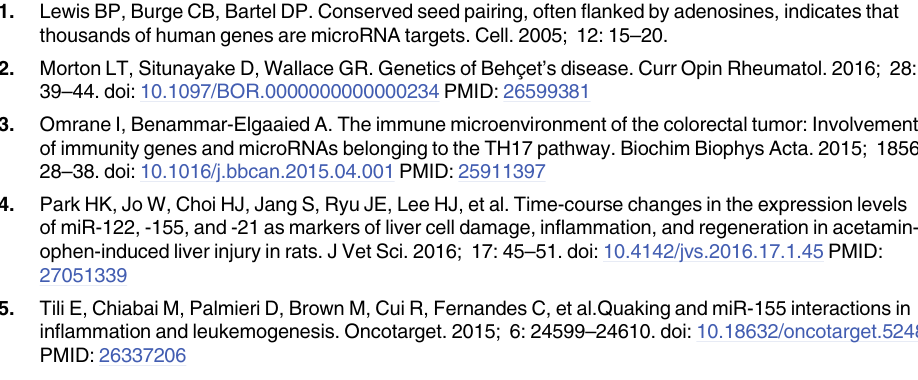
S4 Fig. Genotypes of all mice were distinguished by agarose gel electrophoresis. S1 Table. List of abbreviations.